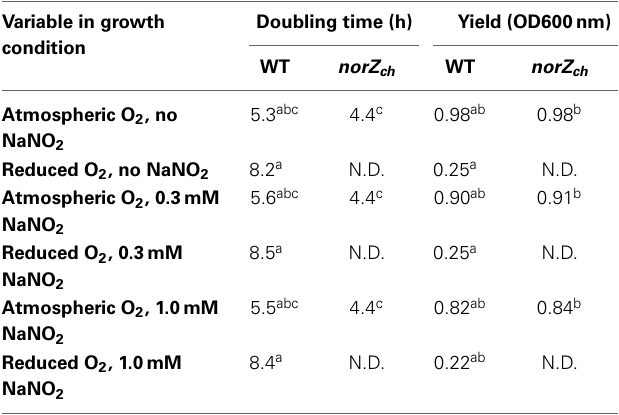
Table 2 | Growth of WT and norZ ch mutant strains of S. wittichii RW1 at variable NaNO 2 and O 2